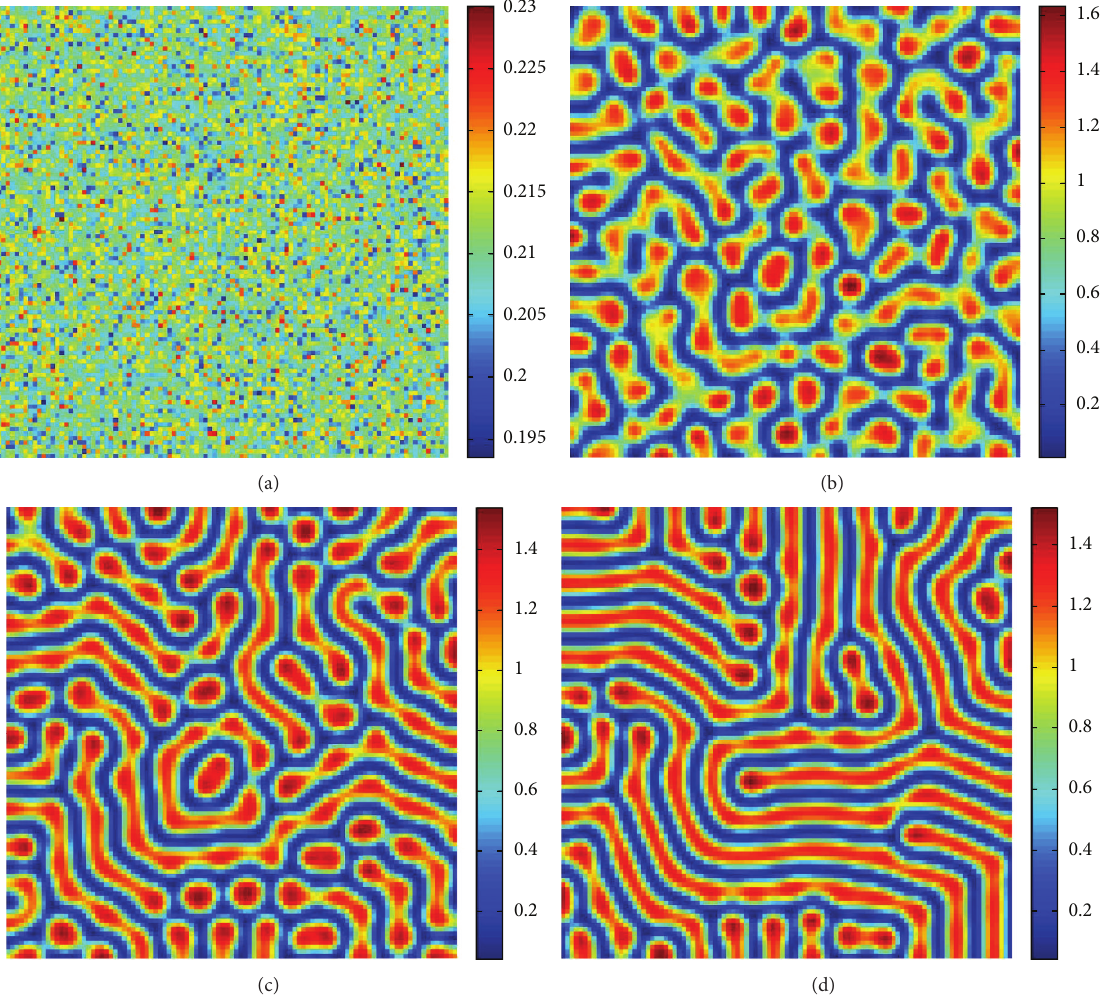
Figure 3: Stripes pattern formation for model (4) by taking 𝑠 = 1 . Other parameters are fixed as (33). Times: (a) 0; (b) 50; (c) 250; (d) 2500.